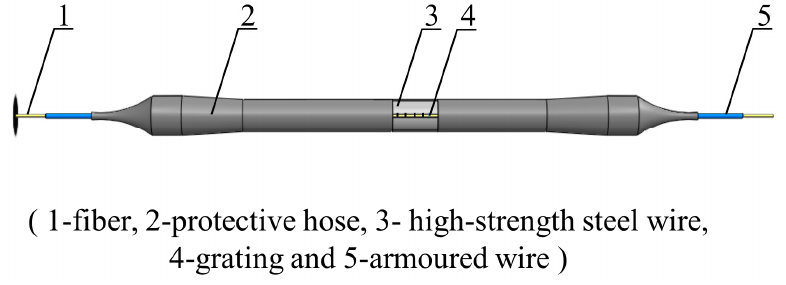
Figure 3. The schematic diagram of the fiber grating type thin rod vibration sensor.